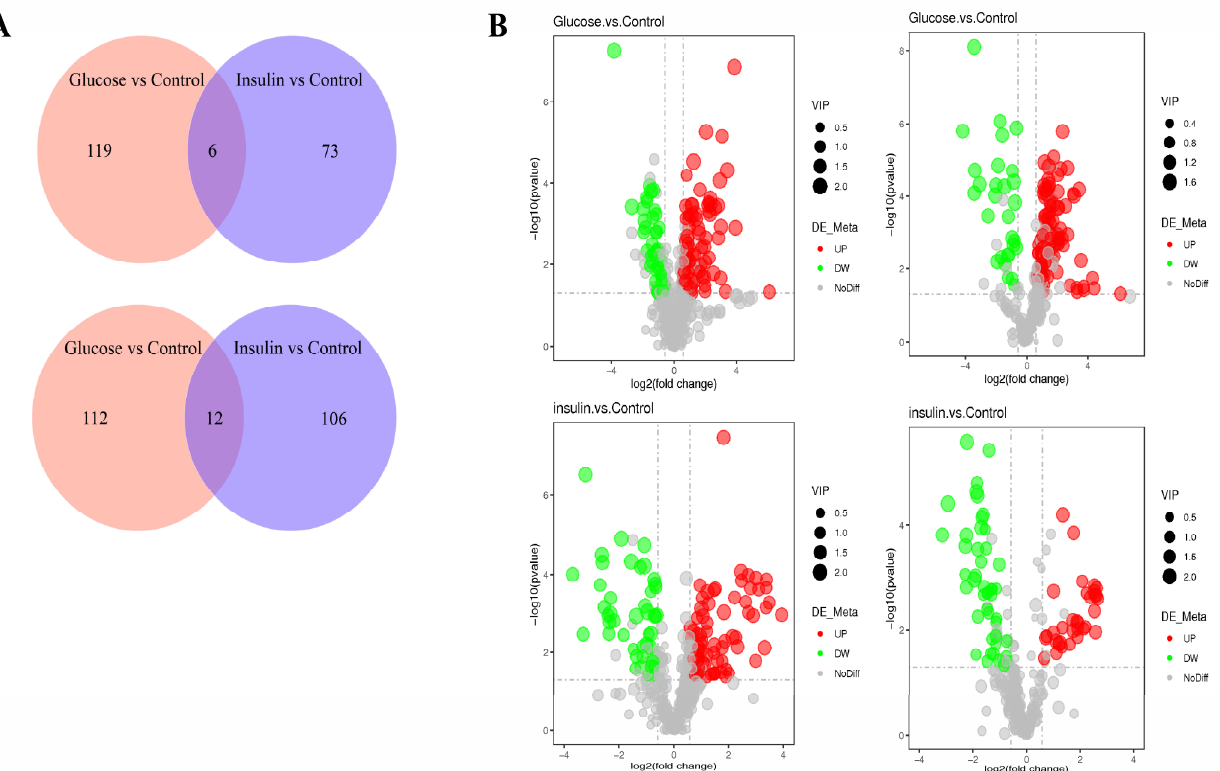
Figure 5. Differential metabolite Venn plots and Volcano plots of acute hyperglycemic/hypoglycemic chickens and control birds. ( A ) Differential metabolite Venn plots for acute hyperglycemic/hypoglycemic chickens and control model. ( B ) Differential metabolites Volcano plots for acute hyper-